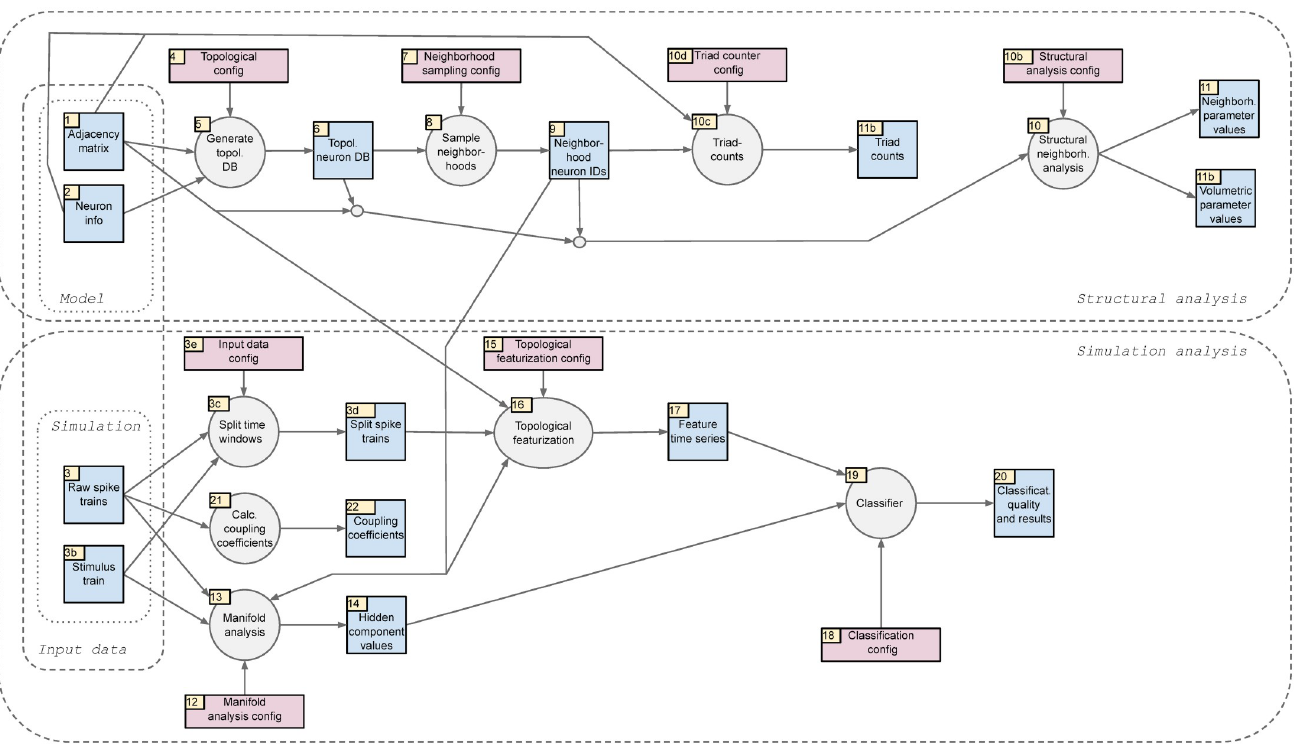
Fig 8. Overview of the inputs into the analysis pipeline and its individual analysis steps.